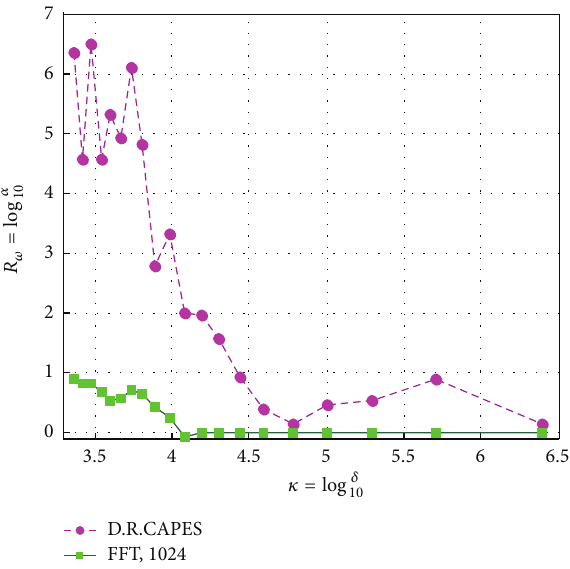
Figure 5: Comparison of frequency resolution between DR-CAPES method and FFT